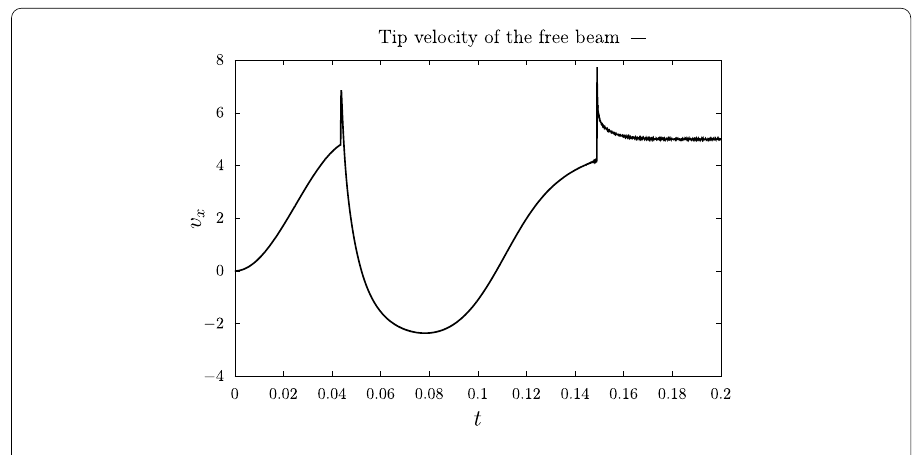
Fig. 16 Tip velocity in x-direction of a free contacting